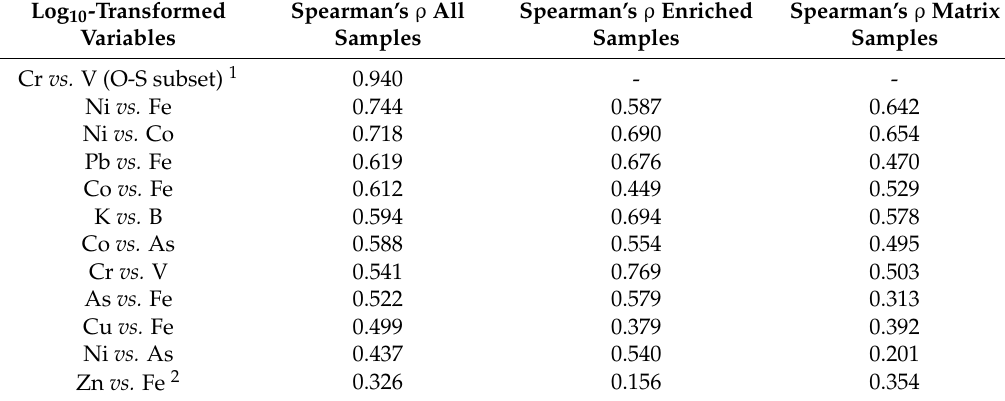
Figure 13. Box-plots on the log 10 scale for selected metals (( A ) As, ( B ) Co, ( C ) Ni, and ( D ) Cu) for 309 samples (single Precambrian point excluded), separated by major stratigraphic units (Figures 2 and 4). Metals concentrations are highest in the Maquoketa-Neda and the Ancell Group, while the Silurian dolostone units tend to have the lowest concentrations for most metals. Colors correspond to those used in Figures 2 and 4. Table 5. Estimated Spearman’s ρ correlations amongst log 10 -transformed variables for selected elements. For all but one of the estimates (Zn vs. Fe of enriched samples), p -values were smaller than 0.02, with most < 0.0001. An expanded analysis showing Pearson’s r , Spearman’s ρ , and all p -values is presented in Supplementary Materials Tables S2C and